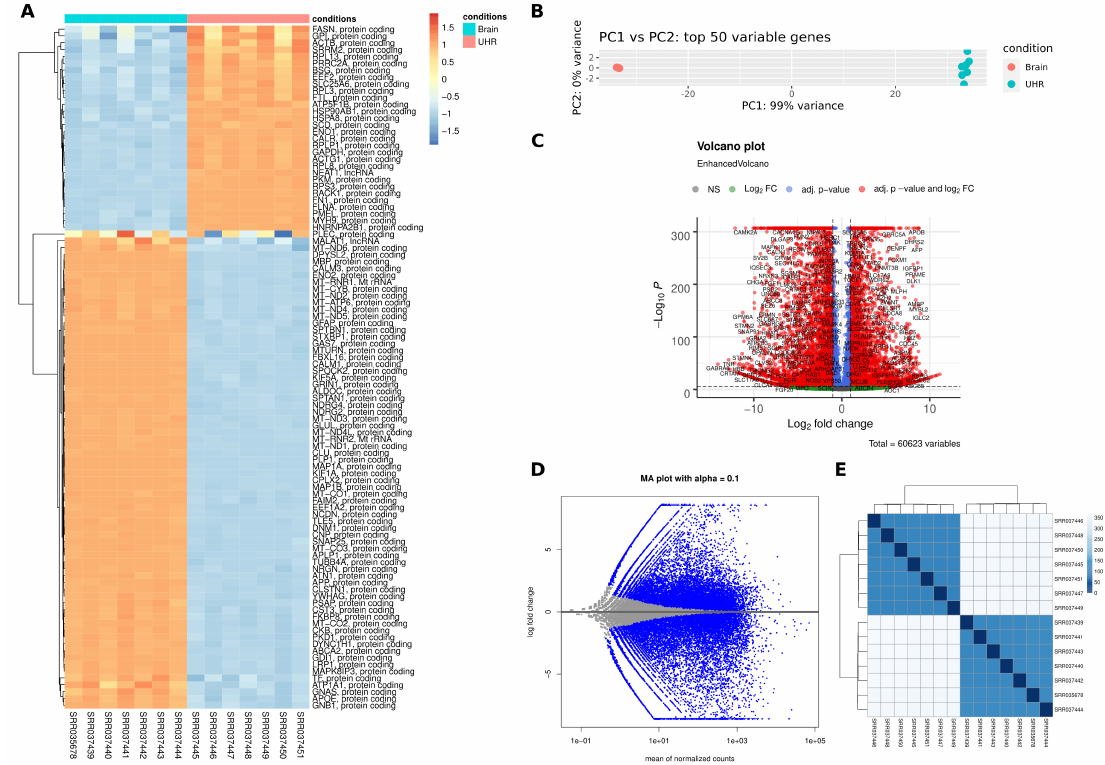
Figure 3. Unmodified visualization plots of a differentially expressed gene (DEG) analysis generated by the pipeline. ( A ) Heatmap on regularized log-transformed counts of the 100 genes with highest gene counts, ( B ) PCA plot on log 2 ( n + 1 ) -transformed counts, ( C ) volcano plot, ( D ) MA-plot, and ( E ) sample-to-sample plot on log-normalized